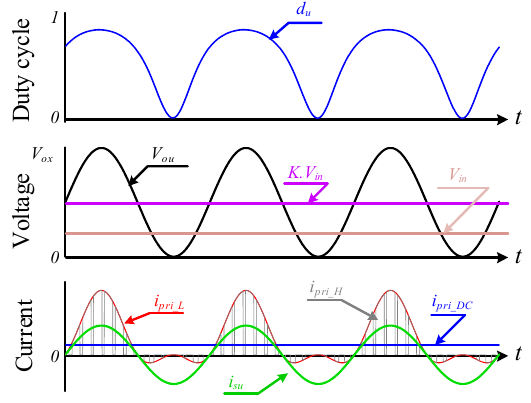
Figure 3. Control waveforms and current/voltage components.